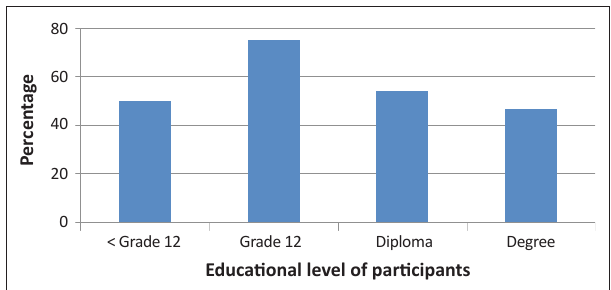
FIGURE 3: Perception of resources necessary to use telemedicine according to qualifications of health care